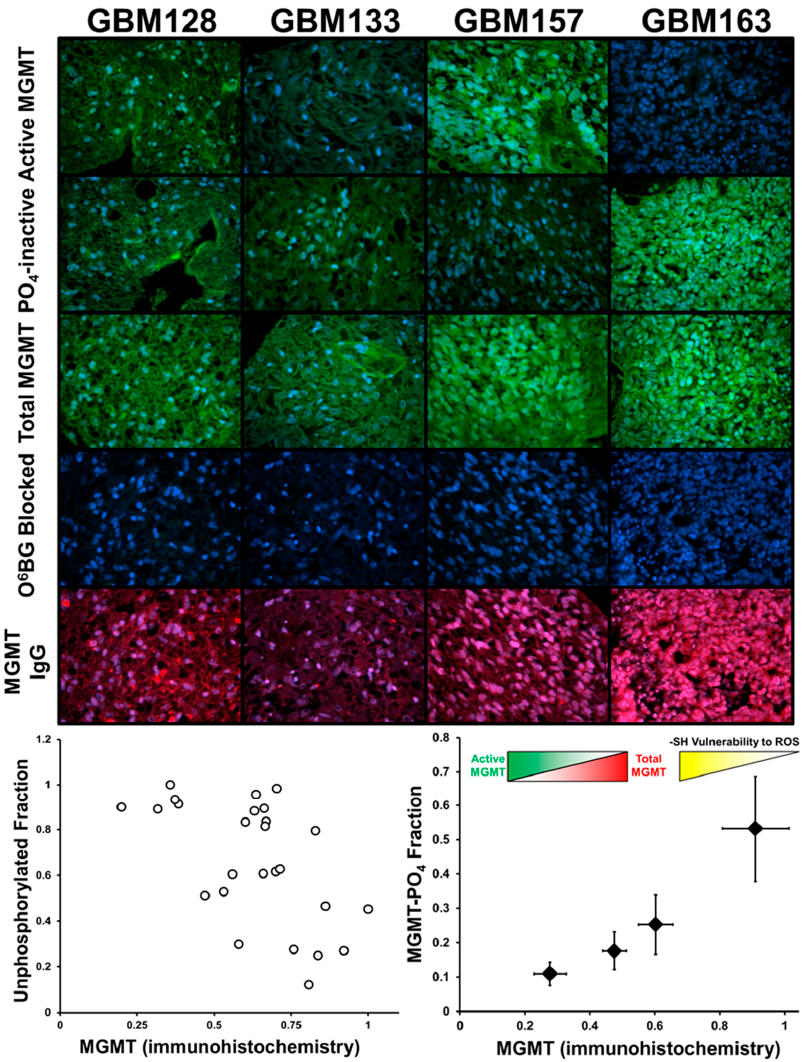
Figure 7. Labeling of MGMT can be done in preserved GBM tumor microarrays after rehydration. Tumor microarrays were rehydrated and then incubated with 100 µ M O 6 PGG followed by labeling with Azido-PEG-FITC and Mitosox. Phosphorylated MGMT was labeled by first treating the tumor microarray with O 6 BG to block active MGMT. Washed cells were then treated with alkaline phosphatase and subsequently incubated with 100 µ M O 6 PGG and labeled with Azido-PEG-FITC. Total MGMT levels (MGMT IgG) were calculated by immunohistochemical staining using an anti-MGMT